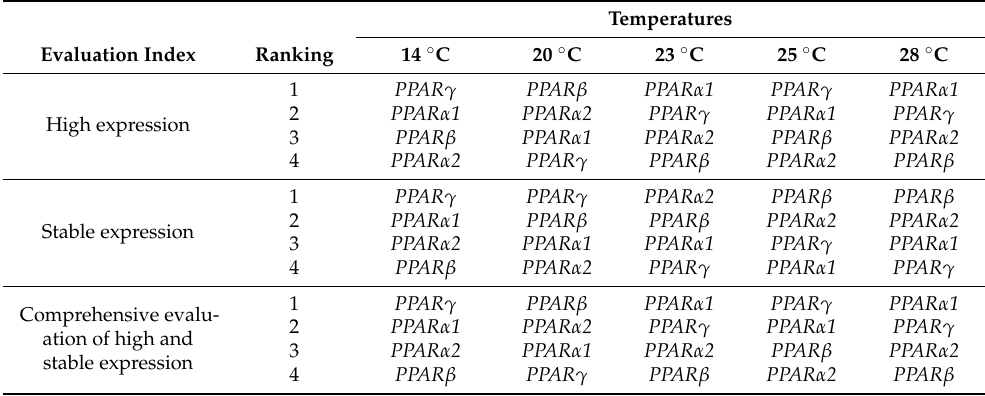
Table 4. Ranking of high expression, stable expression, and comprehensive evaluation of high and stable expression of PPAR genes at different